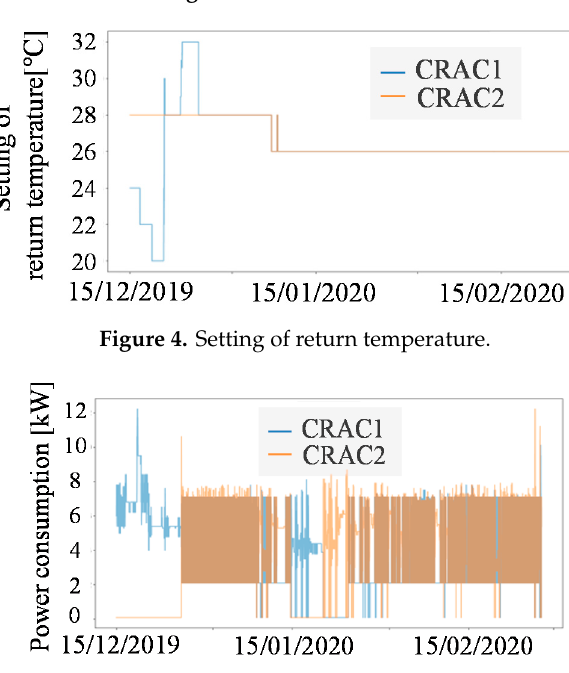
Figure 5. Power consumption of CRAC.